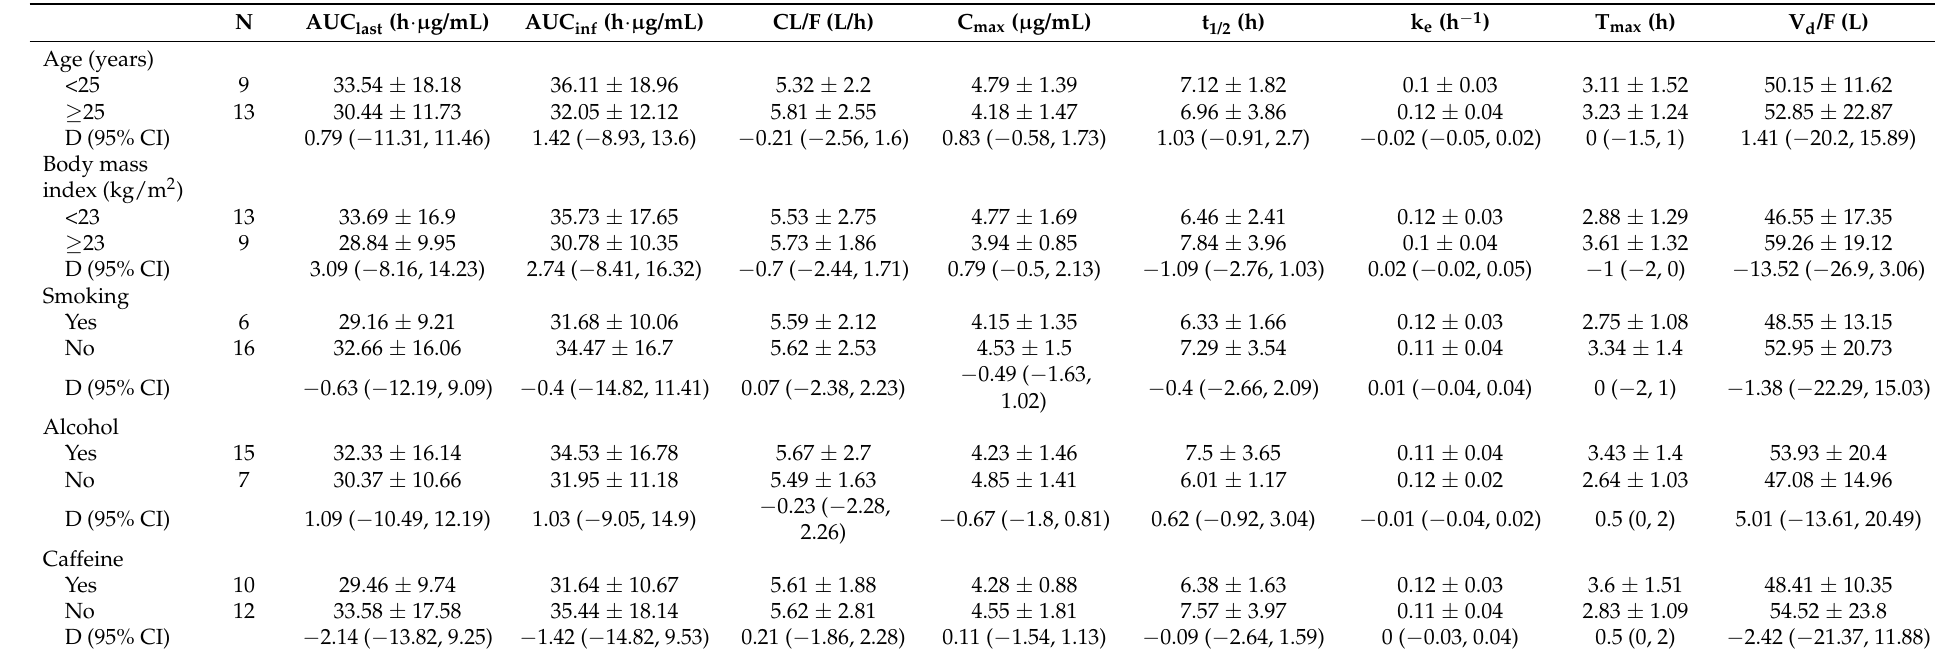
Table 1. Effects of baseline characteristics on valsartan